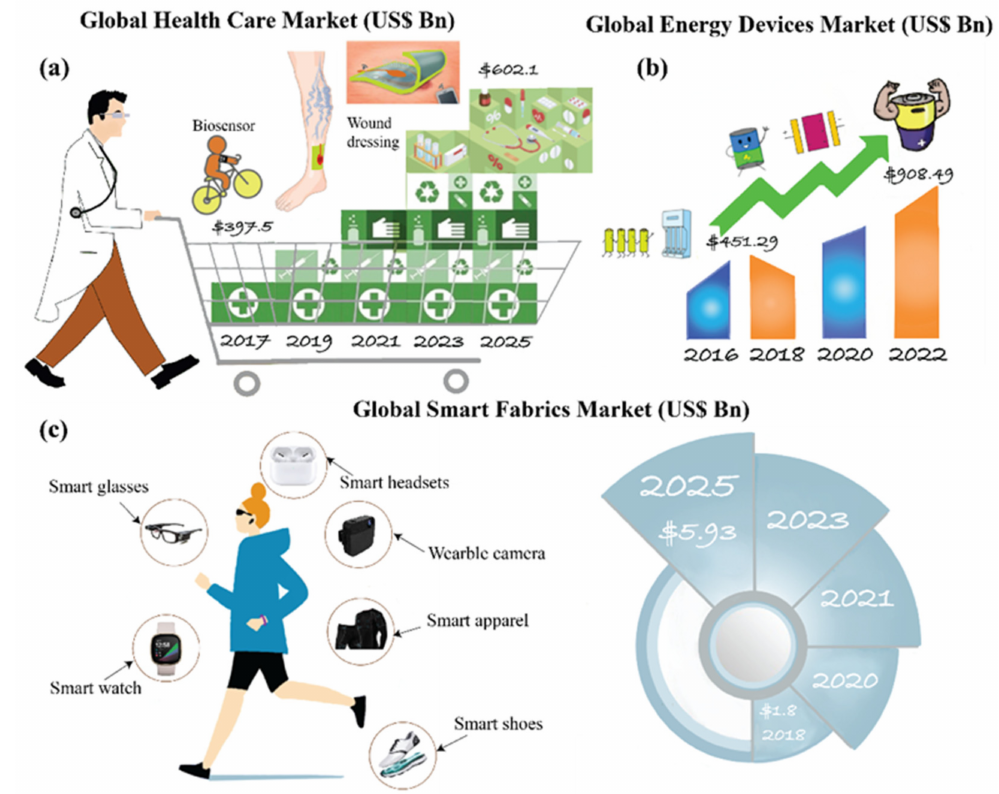
Figure 1. Statistics of ( a ) the global health care market ( b ) the global energy devices market and ( c ) the global smart fabrics